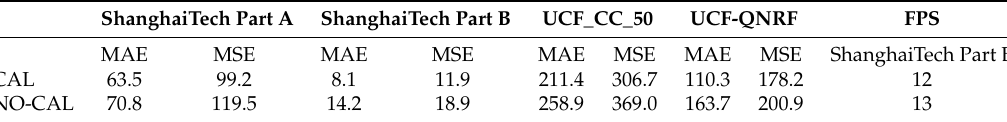
Table 7. The comparison between the NO-CAL structure and our